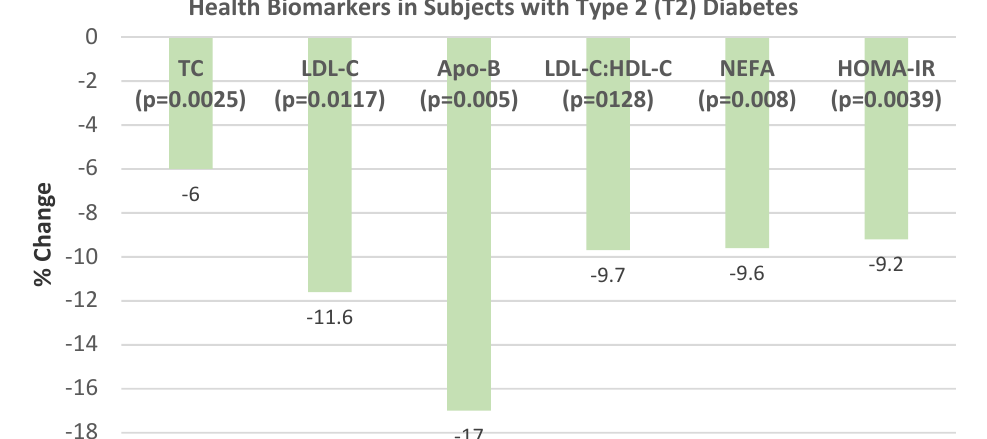
Figure 34. Effect of consuming an almond-supplemented NCEP Step 2 diet relative to a control in T2 diabetic subjects from baseline to 4 weeks [54].